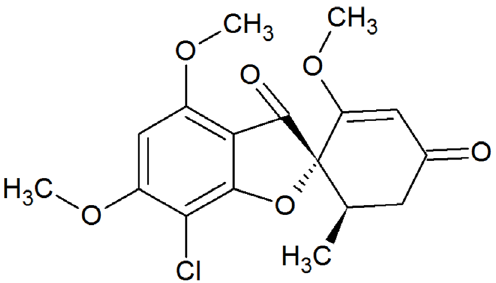
Figure 1 – Chemical structure of griseofulvin